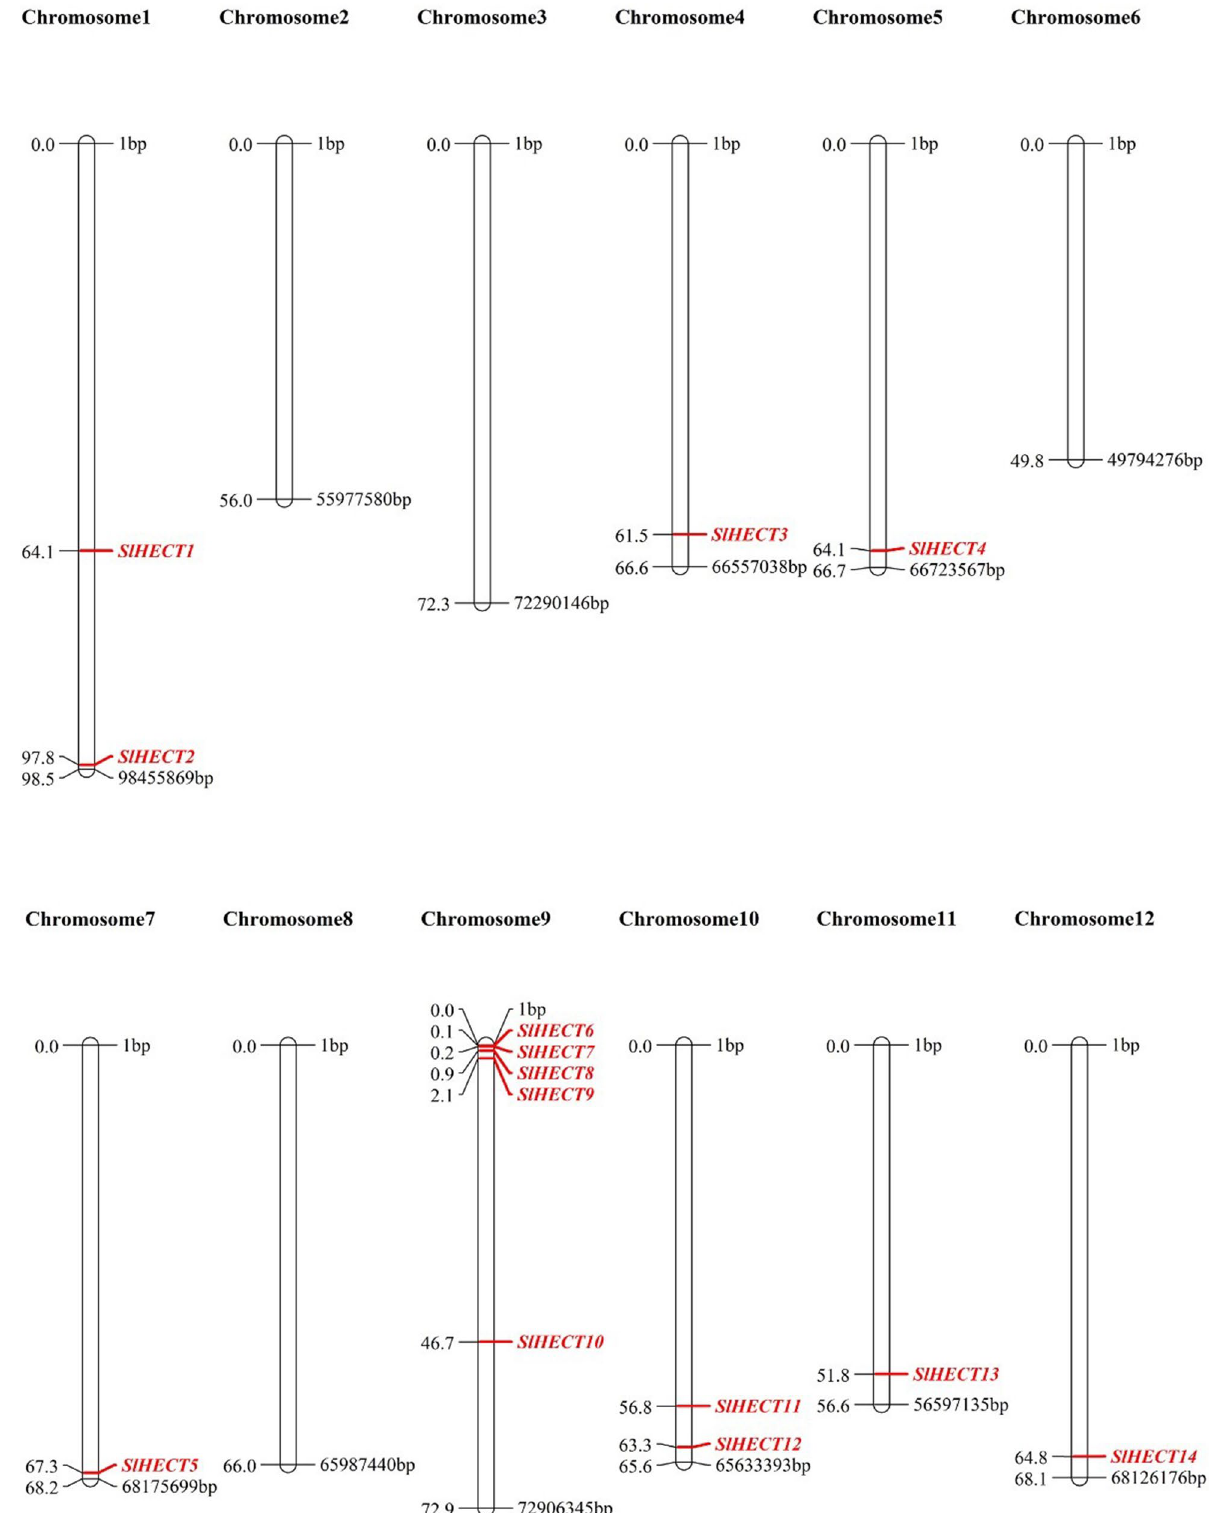
Figure 2. The diagram depicts the chromosomal map of tomato genome constructed using MapChart software (see “Materials and methods” section). All fourteen tomato HECT E3 ubiquitin ligases are localized on respective